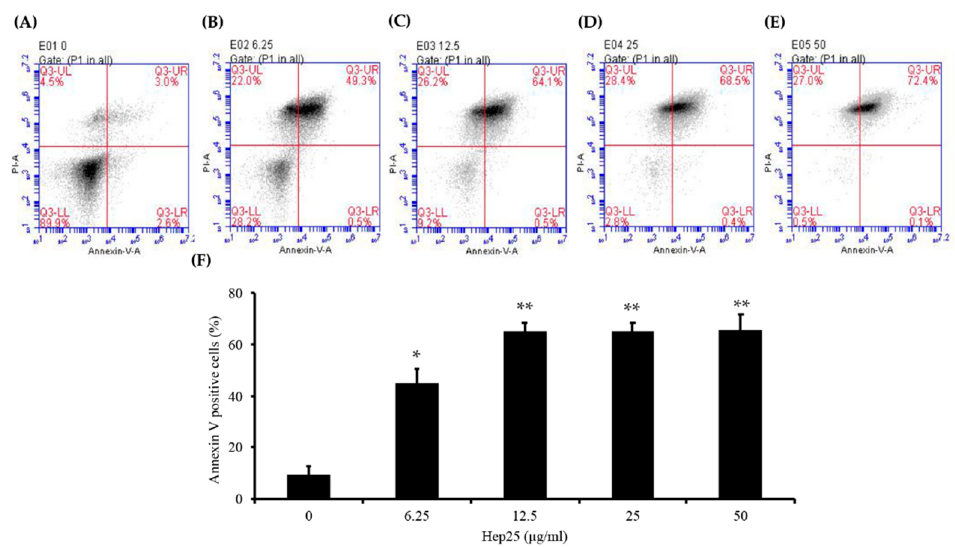
Figure 8. The induction of phosphatidylserine exposure by hep 25. After treatment with various concentrationsofhep25—( A )0,( B )6.25 µ g / mL,( C )12.5 µ g / mL,( D )25 µ g / mL,and( E )50 µ g / mL—protoplasts were stained with Annexin V-FITC and PI and analyzed by flow cytometry. ( F ) The early and late apoptotic cells were stained with Annexin V-FITC (as shown in lower right quadrant, LR and higher right quadrant, UR). The percentage of apoptotic cells in total cell population was calculated. The data represent the mean ± standard deviation for three independent experiments; * p < 0.05; ** p <